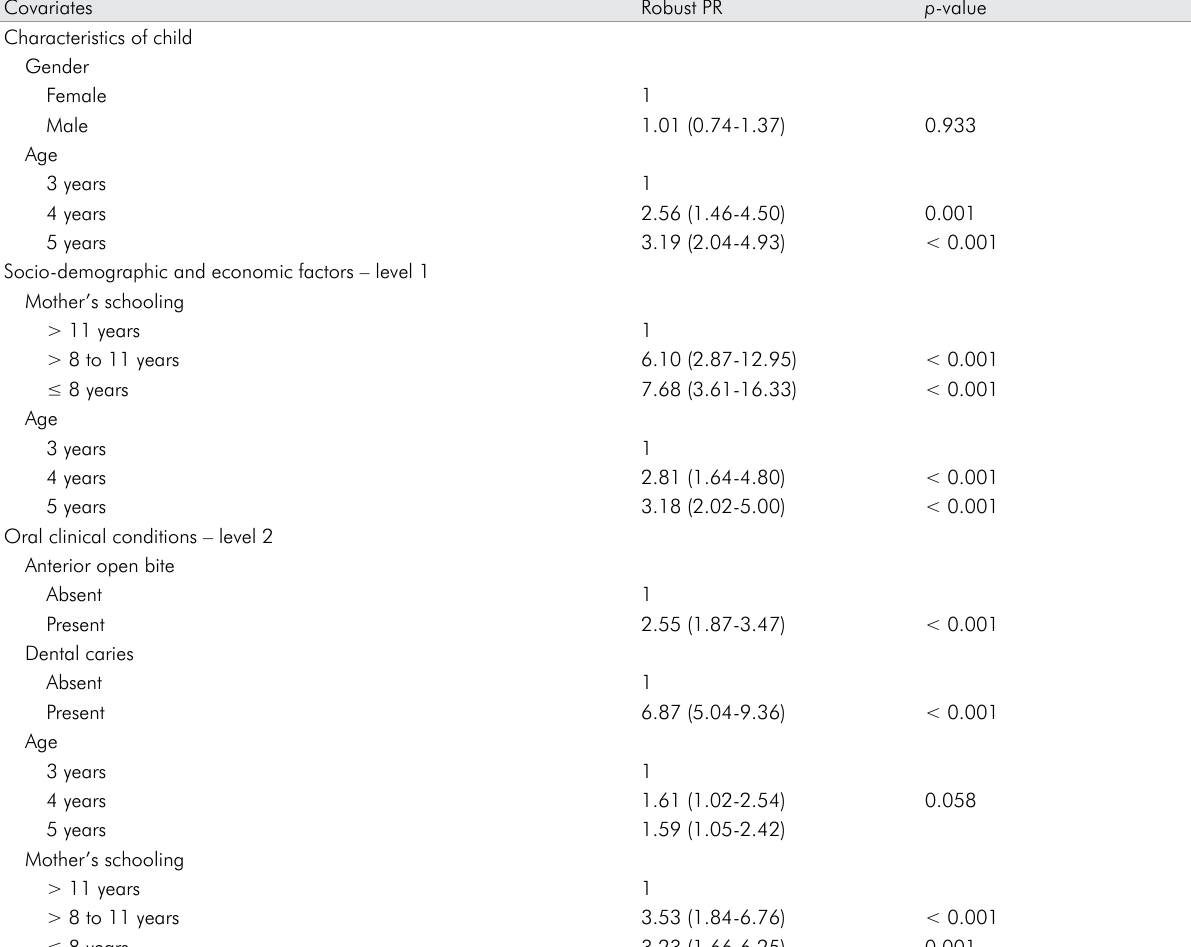
Table 3. Final Poisson regression model for covariates associated with overall ECOHIS. Covariates Robust